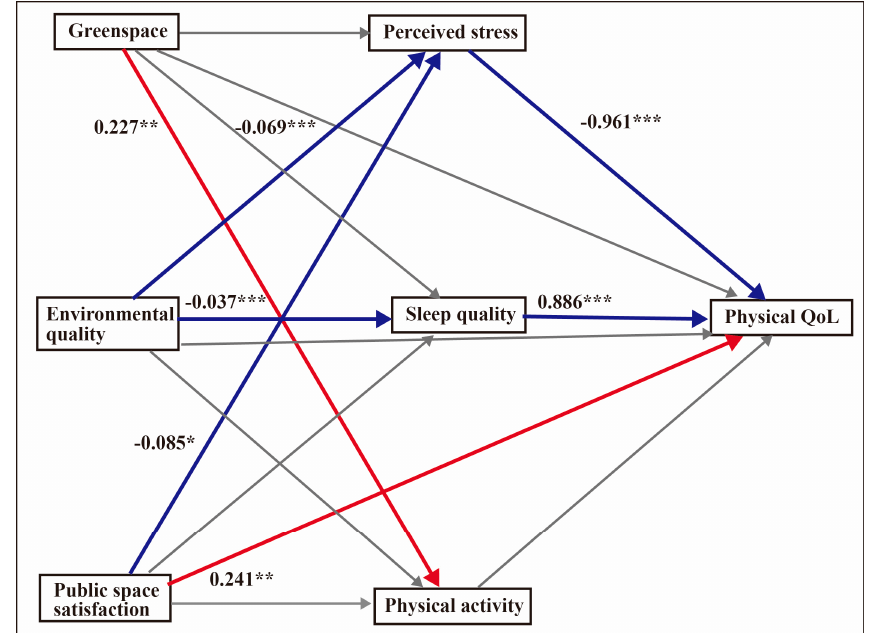
Figure 2. Mediation model for psychological QoL. The analyses controlled for fruit intake and vegetable intake. Unstandardised coefficients are displayed. The values indicate the strength of the relationship between variables. Red arrows depict positive relationships, blue arrows show negative relationships and grey arrows depict non-significance. * p < 0.05, ** p < 0.01, *** p < 0.001.